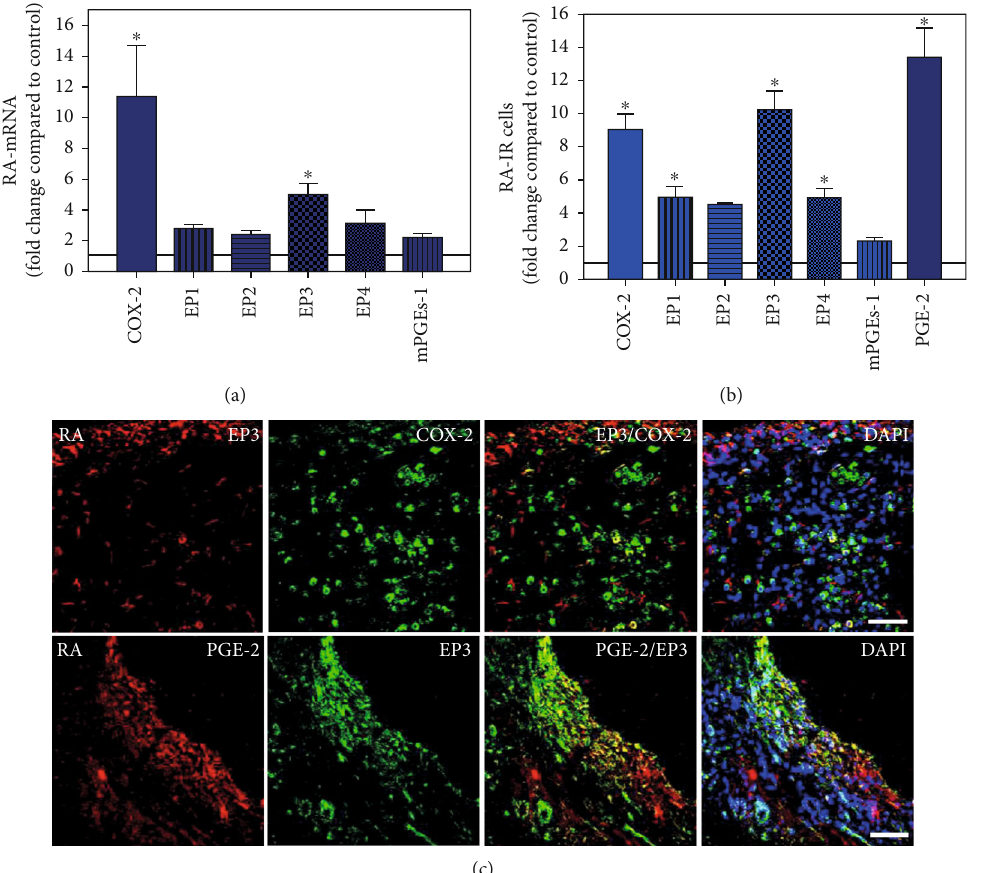
Figure 10: Detection of mRNA (a) and the number cells immunoreactive for di ff erent components of the prostanoid system (PGE2, mPGES, COX-2, and EP1-4) (b) in patients with rheumatoid arthritis (RA). (a) Quanti fi cation of mRNA speci fi c for COX2, EP1-4, and mPGEs-1 in RA synovium. (b) Quantitative analysis of COX2-, EP1-4-, and mPGEs-1-IR cells in rheumatoid synovium. Data are shown as means ± SEM . (c) Confocal microscopy of EP3 (red fl uorescence; a, b) and mPGES or COX2 (green fl uorescence; c, d) double immuno fl uorescence (e – h) in RA synovium. DAPI blue fl uorescence shows nuclear staining. Bar = 40 μ m